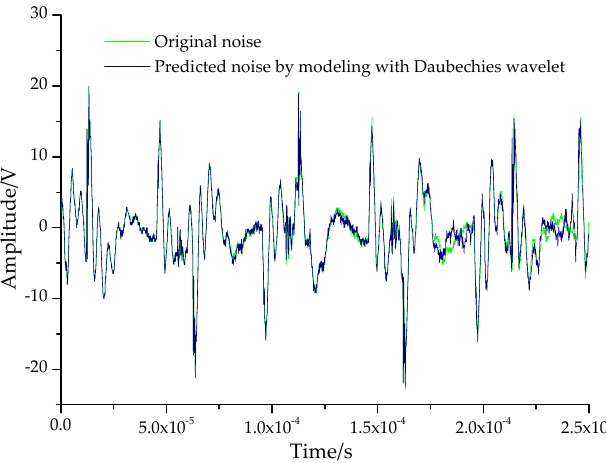
Figure 9. The comparison of time-domain waveforms before and after modeling with biorthogonal wavelet.